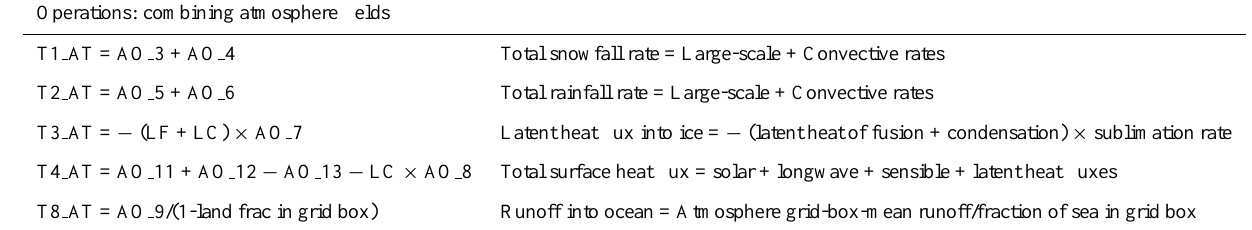
Table 1a. Details of combining the atmosphere fields in Fig. 4. These manipulations are in the UM subroutine OASIS3 GETA2O . Operations: combining atmosphere fields